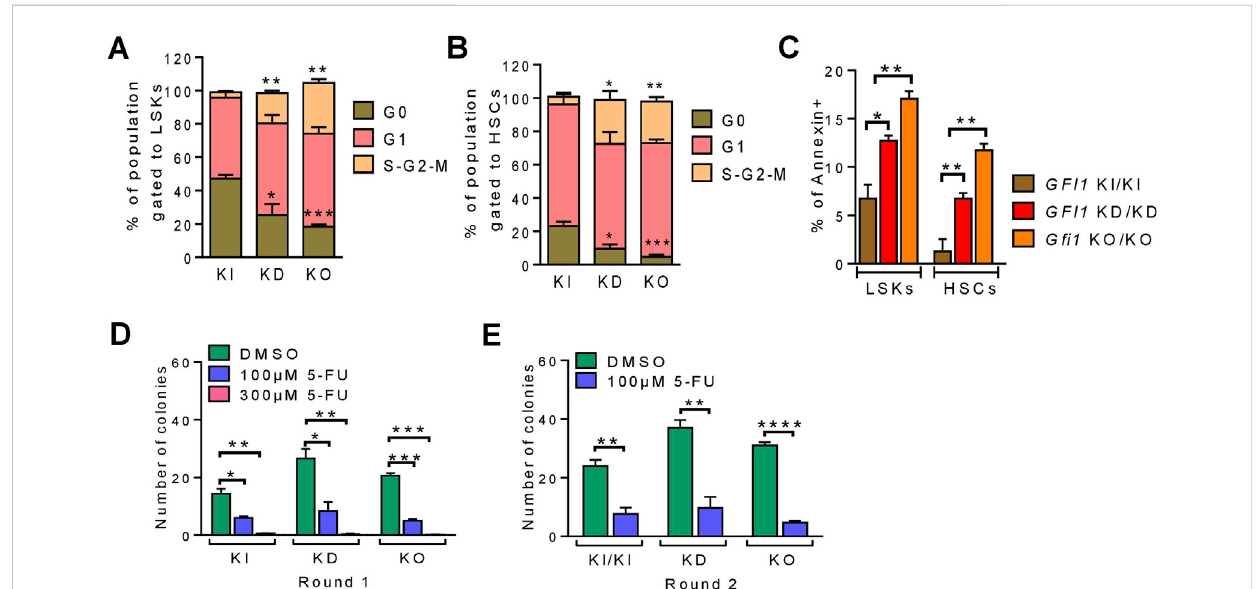
FIGURE 2 Reduced or loss of GFI1 expression resulted in enhanced cell proliferation and apoptosis. (A, B) . The cell cycle status of GFI1- KI, -KD and -KO mice was measured in LSKs and HSCs populations (n ≥ 3; Avg ± SEM; * p ≤ 0.0336; ** p ≤ 0.0027; *** p ≤ 0.0008). (C) . The apoptosis rate of GFI1- WT, -KD and -KO mice was measured by the percentage of annexin-positive cells in LSKs and HSCs populations (n = 3; Avg± SEM; * p = 0.0176; ** p ≤ 0.0093). (D, E) . TheCFUassaywasperformedfromtheHSCsof GFI1 -KI,-KDand-KOmicewithdifferentdosesof5-FUasindicated.Quanti fi cationofthecolonies represents the clonogenic potential of different HSCs populations in different conditions and rounds of plating [ fi rst round (D) and second round (E) ] (n = 3; Avg ± SEM; * p ≤ 0.0151; ** p ≤ 0.0069; *** p ≤ 0.0004; **** p ≤